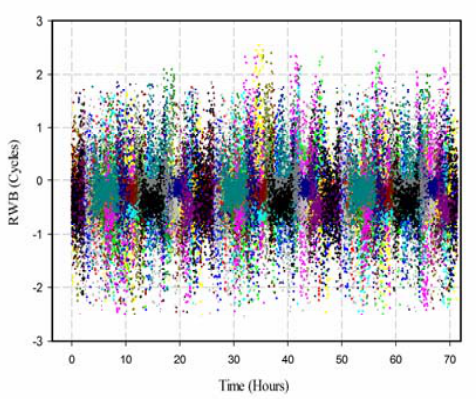
Figure 4. Three Days of RWB at ULAB IGS-MGEX Station